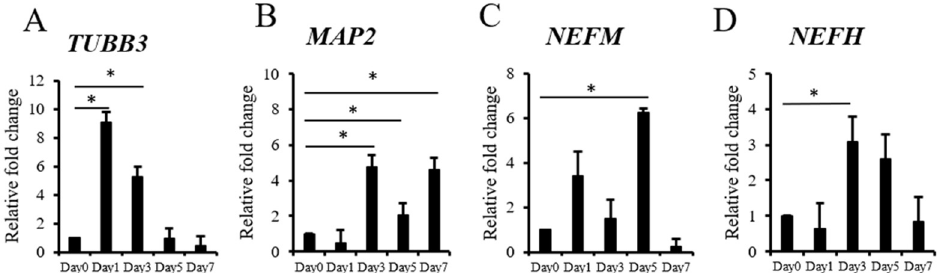
Figure 1. Neuron-related gene expressions of the ADSCs during confluence-initiated differentiation. The time course experiments of detecting neuron-associated gene expressions include class III β -tubulin ( TUBB3 ) ( A ), microtubule-associated protein 2 ( MAP2 ) ( B ), neurofilament medium polypeptide ( NEFM ) ( C ), and neurofilament heavy polypeptide ( NEFH ) ( D ) in the spontaneously differentiated ADSCs after high confluence was achieved in the cultures by RT-qPCR. The value of each gene expression was normalized to the expression of glyceraldehyde-3-phosphate dehydrogenase ( GAPDH ). Relative fold changes of the values from day 1 to day 7 were compared with the value of day 0 (without induction) as one. The values are expressed as mean ± S.D. with three experimental replicates. Statistical significance was determined using the Mann–Whitney U test. “*” represents p < 0.05.